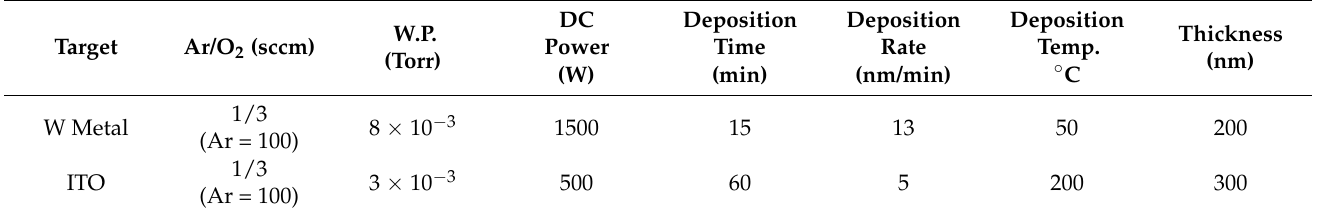
Table 2. Deposition parameters of WO 3 electrode film and ITO